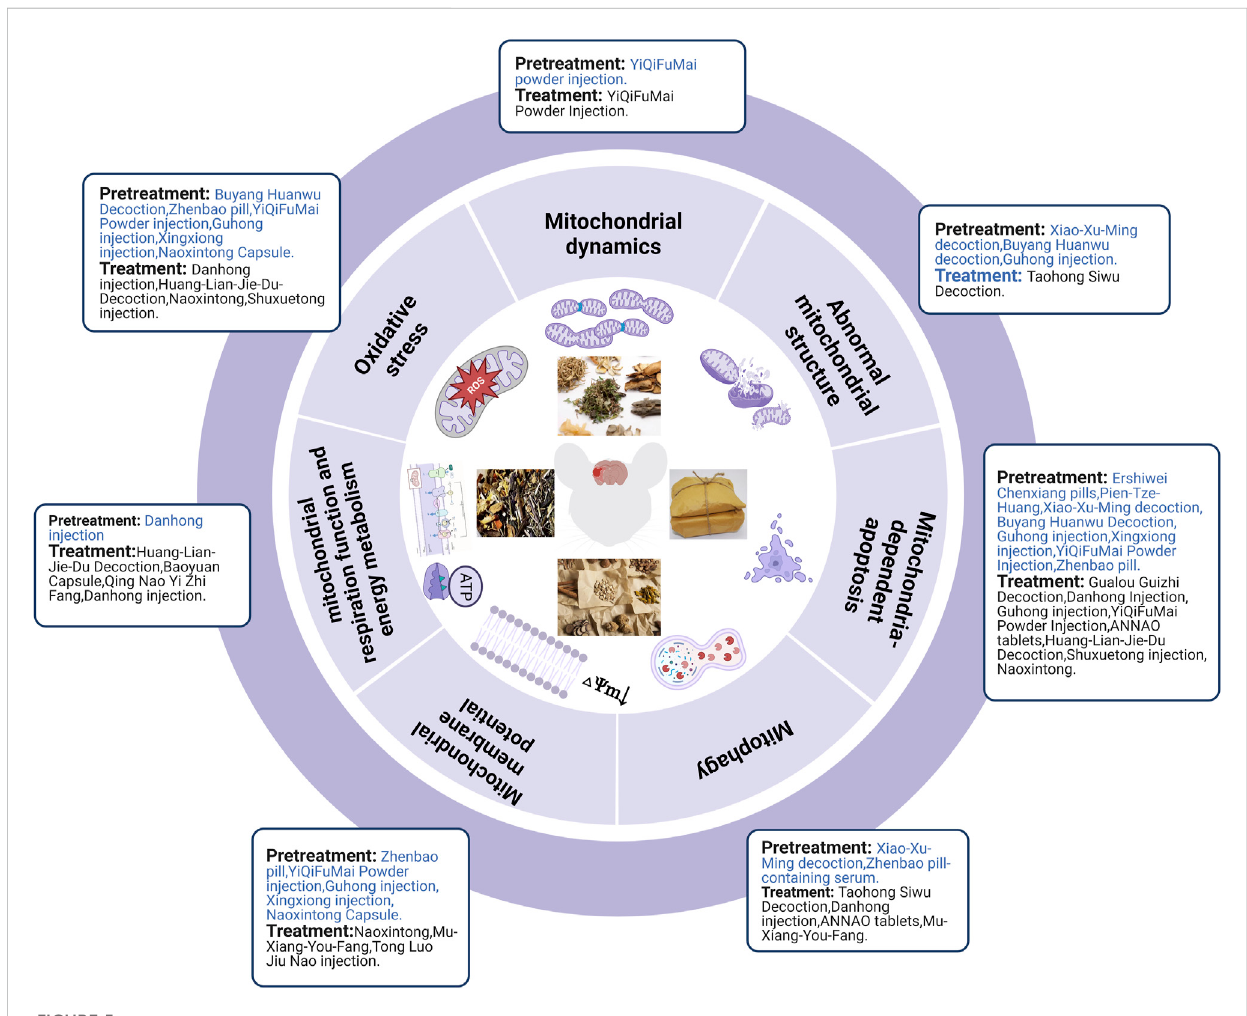
TCM prescriptions prevented and treated ischemic stroke by regulating